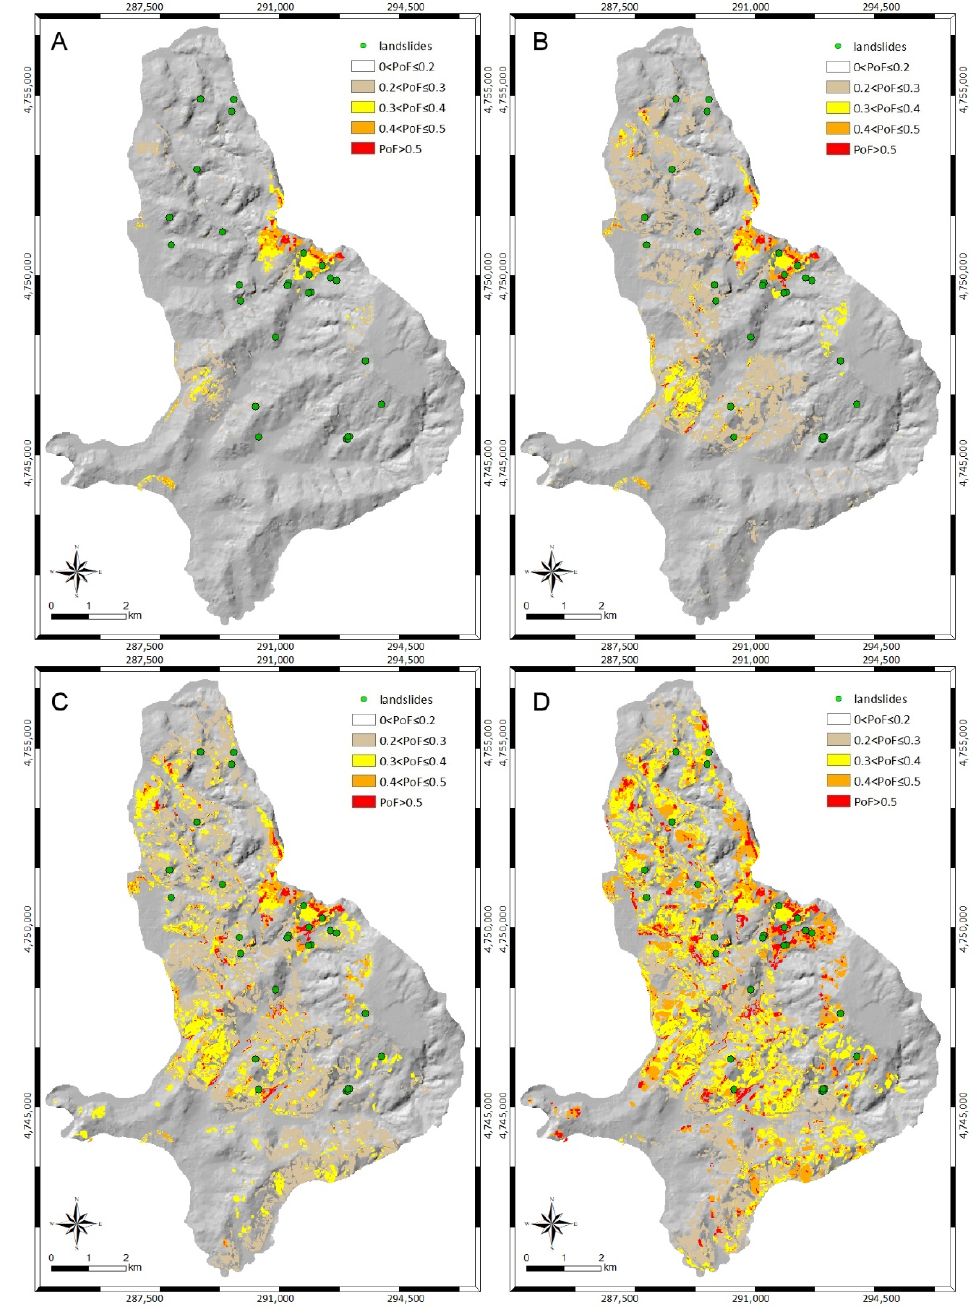
Figure 7. Spatial distribution of PoF considering a reduction of c ′ in arable areas equal to 20% ( A ), 30% ( B ), 40% ( C ), and 50% ( D ).